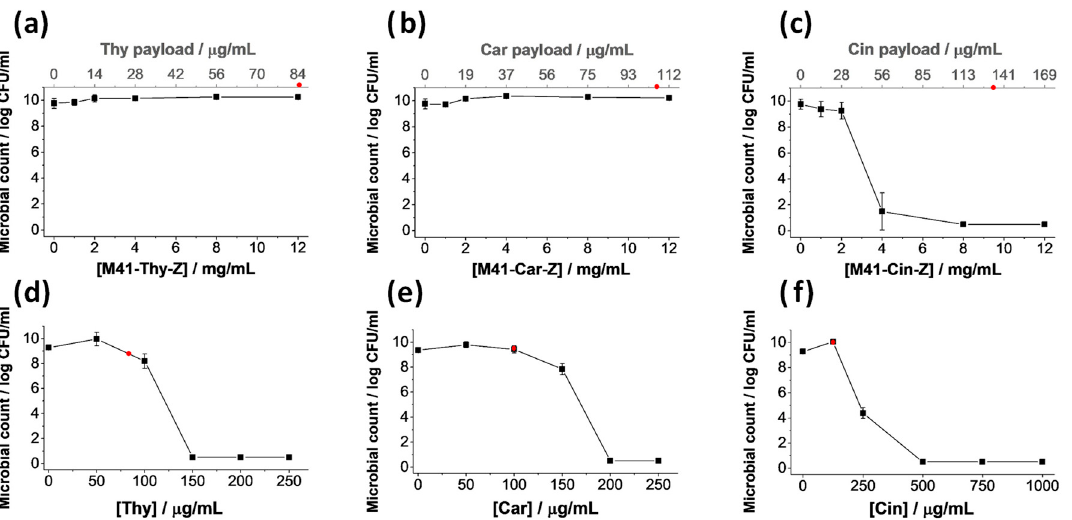
Figure 7. E. coli counts after incubation with M41–EOC–Z systems (M41-Thy-Z ( a ), M41–Car–Z ( b ) and M41–Cin–Z ( c )) and free EOCs (thymol ( d ), carvacrol ( e ) and cinnamaldehyde ( f )) according to particle and EOC concentration. Red dots mark the coincidental concentrations between the encapsulated EOC and the free molecule. Antimicrobial assays were performed in triplicate, and error bars correspond to the standard deviation.